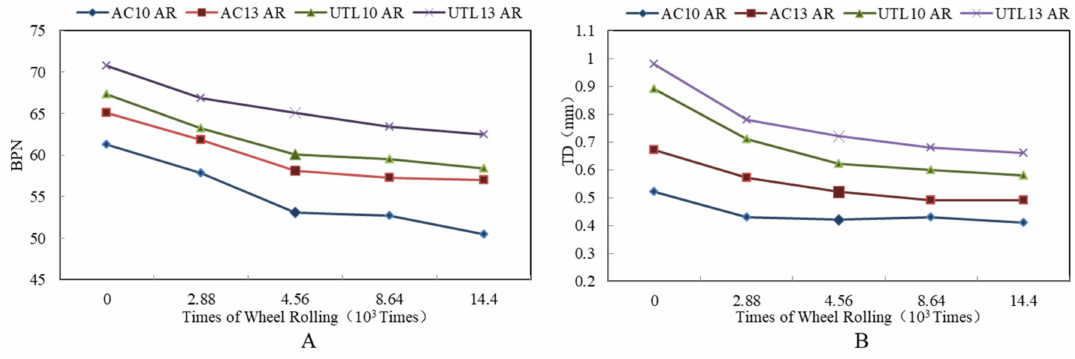
Figure 12. Attenuation rules of skid resistance indexes with di ff erent gradations: ( A ) BPN; ( B )